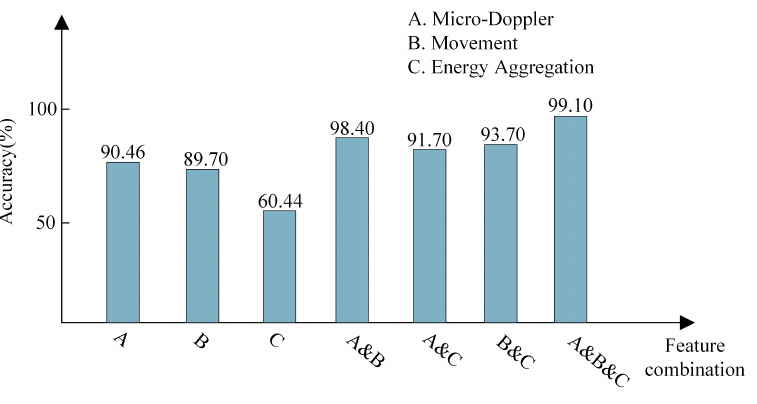
Figure 8. Impact of the classification accuracy for different combinations of